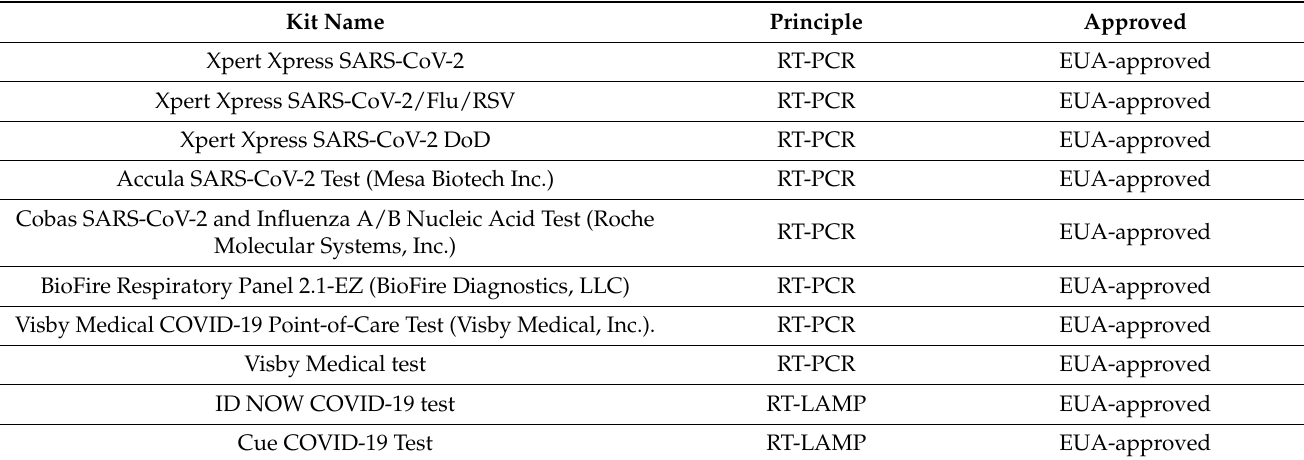
Table 4. List of EUA-approved POC devices working on RT-PCR/RT-LAMP for SARS-CoV-19 detection.